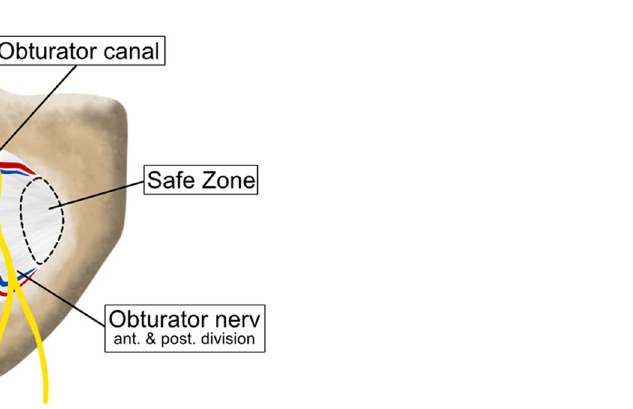
Figure 7. Schematic illustration of the obturator foramen. The obturator artery divides into medial and lateral branches as it emerges from the obturator canal. An acetabular branch rises from the lateral part and runs towards the hip joint. The obturator nerve divides into anterior (Pectineus m., Adductor longus m., Adductor brevis m. Gracilis m.) and posterior divisions (Obturator externus m., Adductor magnus m.). At the medial border, a safe zone can be identified in which the cable wire can be passed with limited